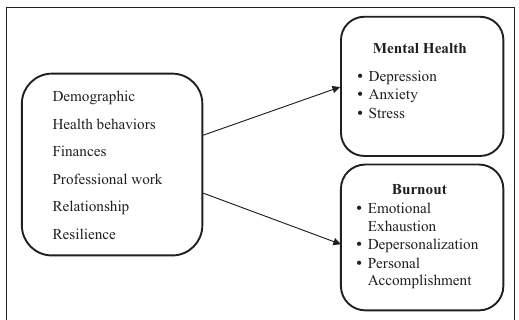
Figure 1. Conceptual